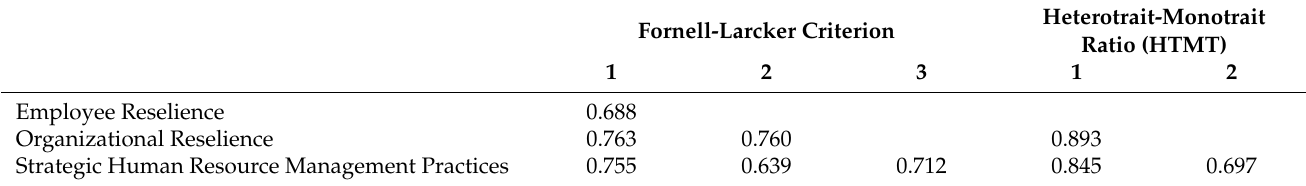
Table 3. Discriminant